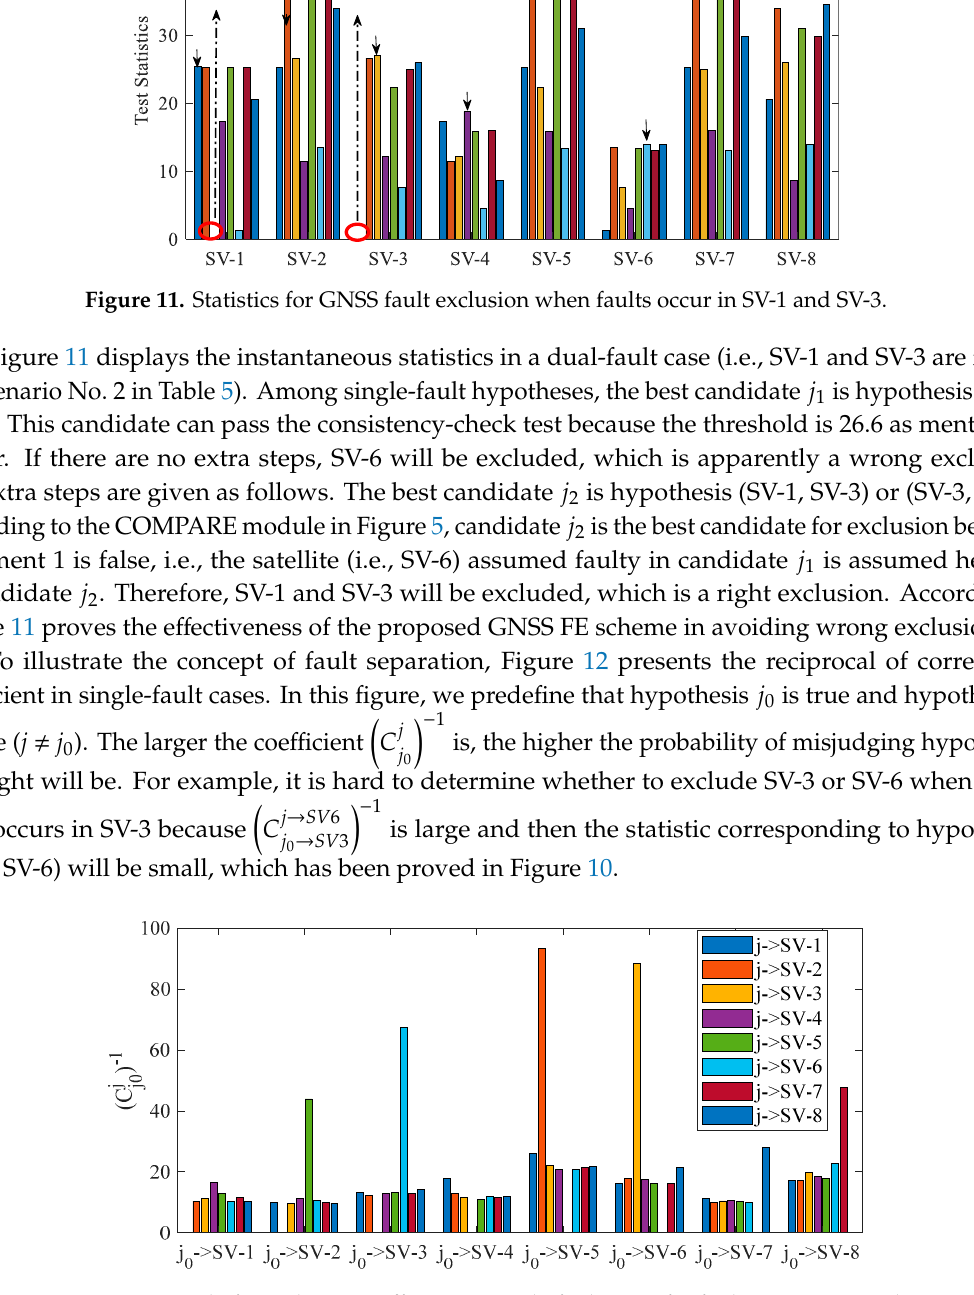
Figure 12. Reciprocal of correlation coefficient in single-fault cases for fault separation evaluation. FF detection should be repeated after GNSS fault exclusion to eliminate the e ff ects of GNSS